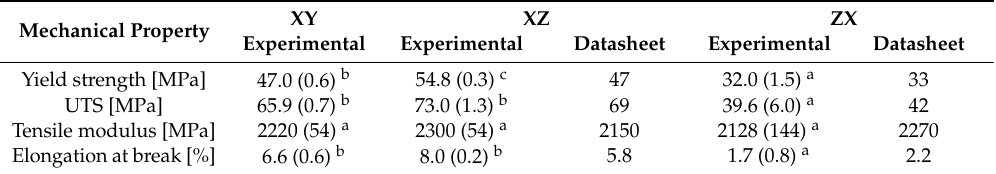
Table 3. Results of tensile properties of Ultem 9085 samples built according the three building directions XY, XZ, and ZX, mean values, and standard deviations (in parentheses). Superscript letters indicate statistically-homogeneous subsets (Tukey’s HSD test, α =